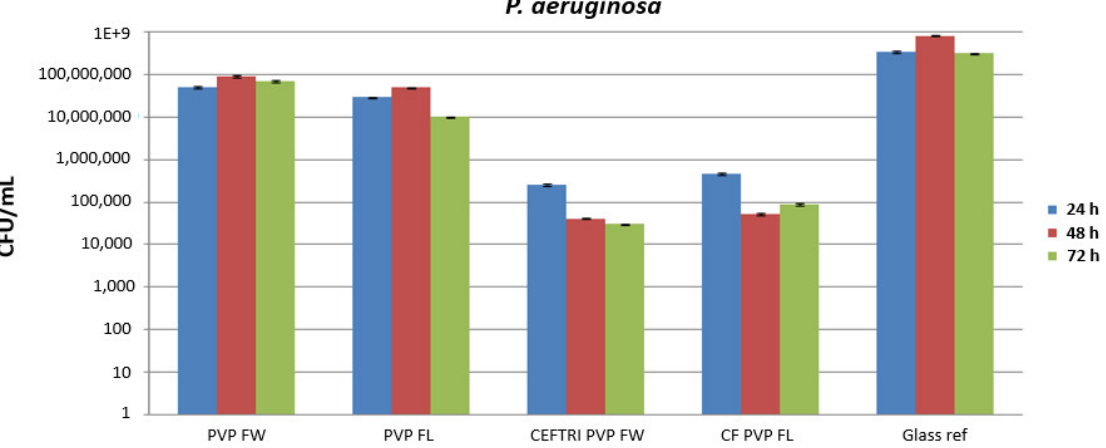
Figure 7. Biofilm formation results of the S. aureus tested strain, developed on nanomodified surfaces MAPLE-deposited at 200 mJ/cm 2 laser fluence for 24, 48, and 72 h. Results represented on the Y-axis refer to log 10 CFU/mL.